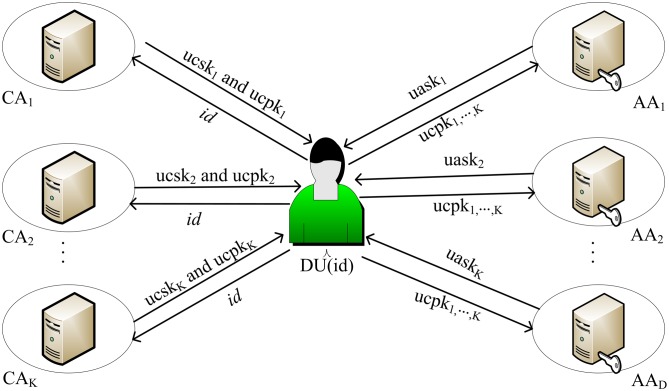
CAS and AAS send key for user id.